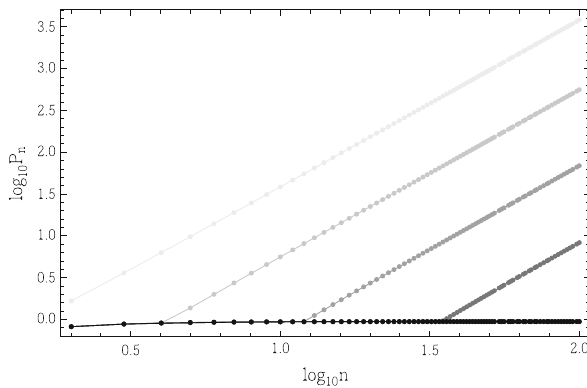
Fig. 6 The time evolution of power spectrum in the case of ˜ m = H 0 , √ H 0 = 8 π/ 3. The darker curves correspond to the spectra at later times. The lightest curve is the initial Lorentzian spectrum at time t i . For each n mode, the power is evaluated up to its horizon crossing time